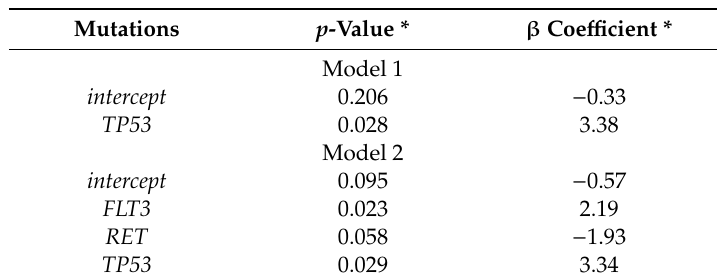
Table 2. The coe ffi cients necessary to determine the predicted risk of follicular thyroid carcinoma (FTC) and follicular thyroid adenoma (FTA) on the basis of single mutation TP53 -Model 1 and the group of the mutations (comprising FLT3 + TP53 + RET ) selected in the backward stepwise logistic regression-Model 2.